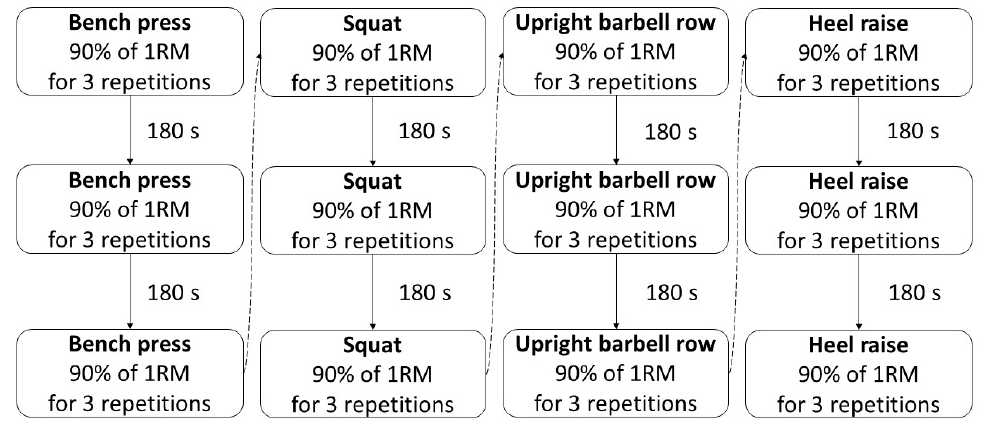
Figure 2. TRT Figure 2. TRT protocol.